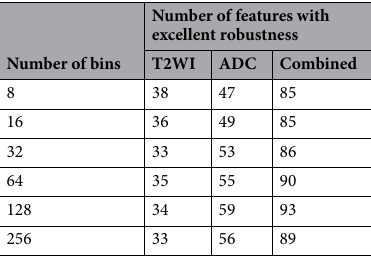
Table 2. Number of features with high robustness (ICC > 0.8) by varying the number of bins in the quantisation step for radiomic feature extraction for T2w and ADC MR images separately.